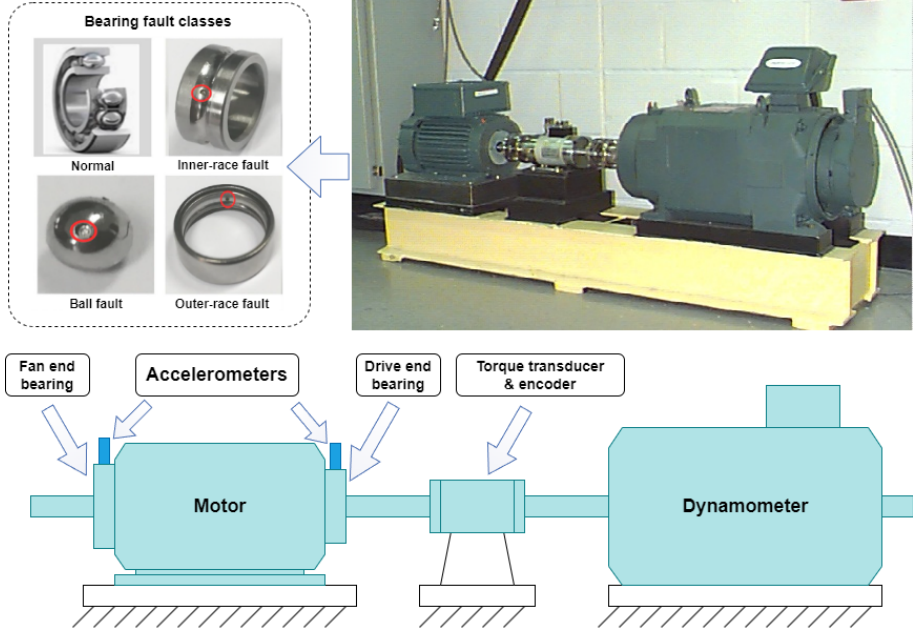
Figure 5. The bearing fault experiment platform of CWRU and the bearing fault classes.